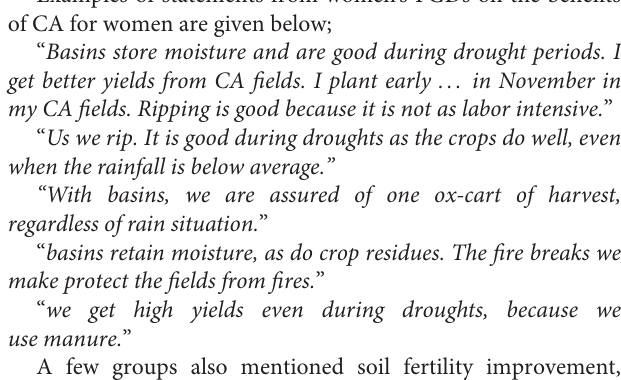
laborious. The desire for men to control cash incomes seemed to trump any other